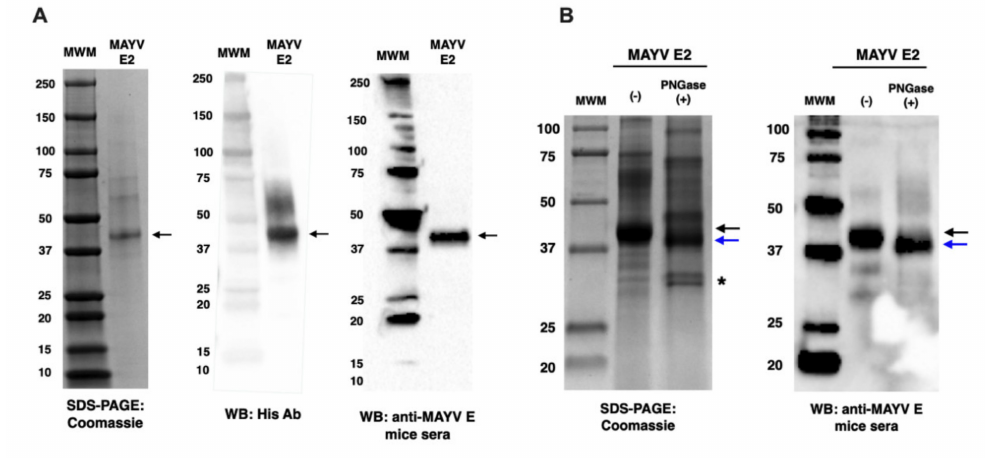
Figure 2. Characterisation of MAYV E2 glycoprotein. ( A ) Purified MAYV E2 glycoprotein was analysed by SDS-PAGE following Coomassie-staining gel or WB analysis using an anti-His tag antibody or anti-MAYV E reactive mice sera. The arrow indicates the band specific to MAYV E2. ( B ) N-glycosylation of MAYV E2 glycoprotein was analysed by SDS-PAGE Coomassie-stained gel and WB with anti-MAYV E reactive mice sera. Samples were either loaded without PNGase F treatment (-) or with PNGase F treatment (+). The black and blue arrows indicate the band specific to MAYV E2 without PNGase F treatment (-) or with PNGase F treatment (+), respectively. The symbol (*) indicates the band specific to PNGase F